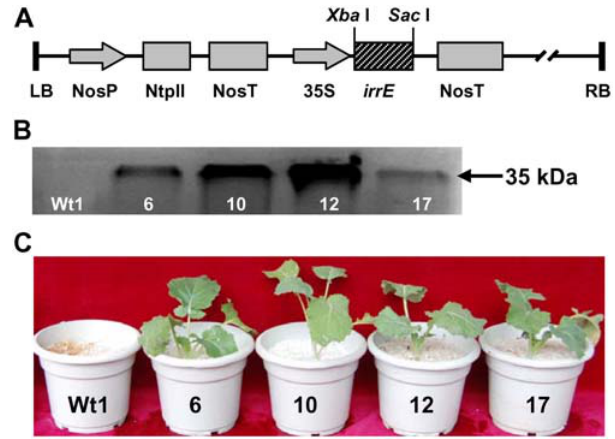
Figure 2. Overexpression of IrrE improves salt tolerance in B. napus plants. ( A ) Diagram of the P 35S :IrrE construct; ( B ) Western blot analysis of IrrE in wild-type plant (Wt1) and transgenic lines no.6, 10, 12, 17. Molecular mass is indicated on the right; ( C ) Salt treatment of Wt1 and representative transgenic plants. After 350 mM NaCl treatment for six weeks, representative plants were photographed.